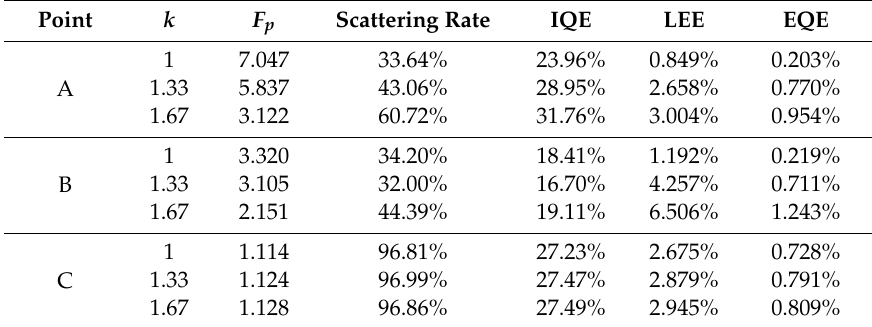
Table 1. Purcell Factor, Scattering Rate, internal quantum e ffi ciency (IQE), light extraction e ffi ciency (LEE), and external quantum e ffi ciency (EQE) at 551 nm for the q-dipole in the three-body system with the z-dipole placed at di ff erent points and di ff erent aspect factor k of the Ag NP. Point k F p Scattering Rate IQE LEE EQE A